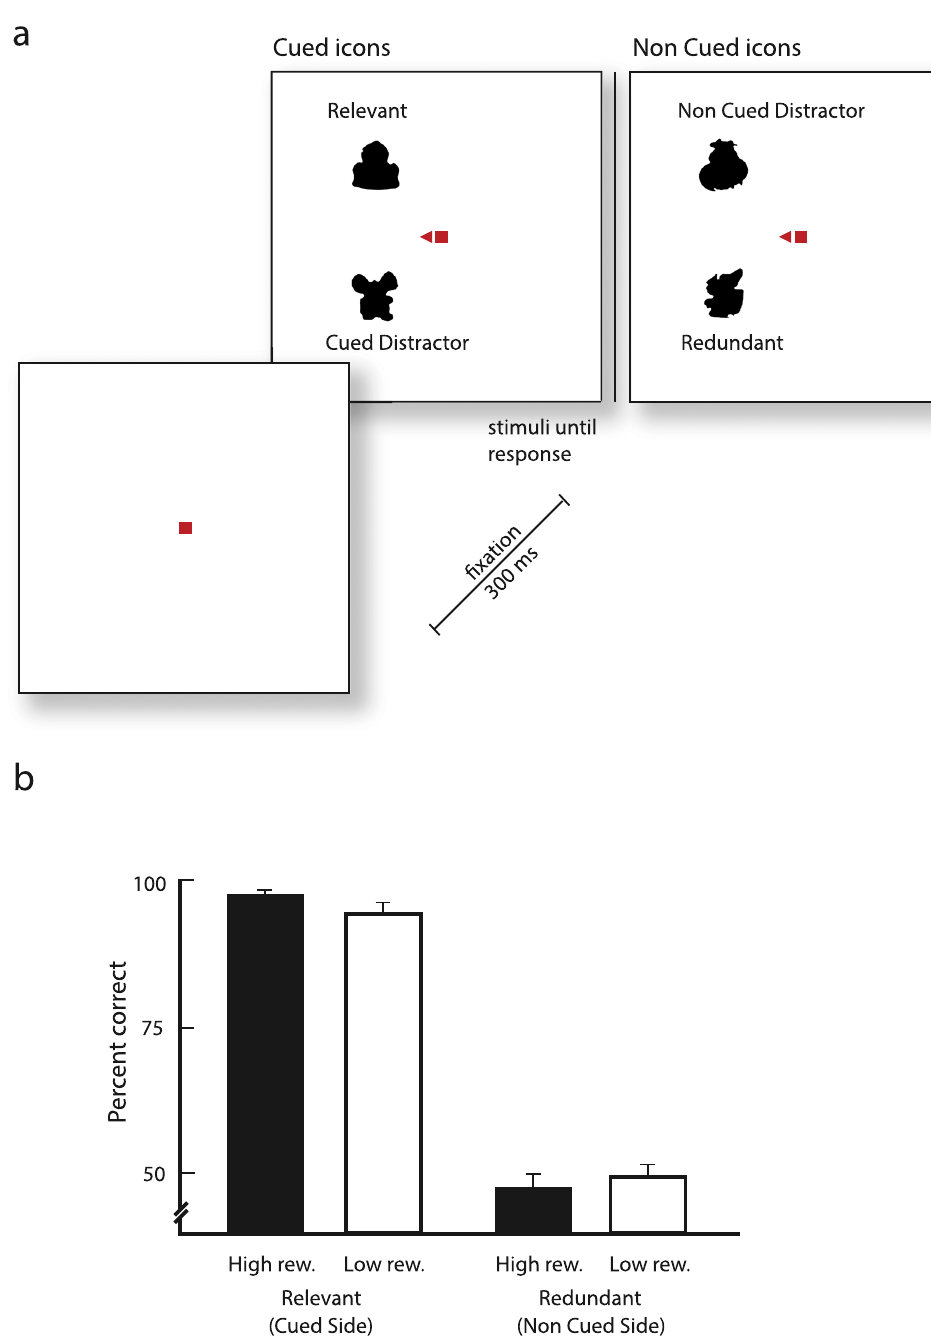
Figure 2. Probe task testing the influence of attention on learning. ( a ) Trial structure. Participants saw icons that had been cued during learning (a relevant icon and a cued distractor) or icons that had not been cued (a redundant icon and a non-cued distractor). We gave no feedback on whether the response was correct or erroneous to prevent additional learning. ( b ) Accuracy in the probe task for icons that had or had not been cued during learning. Black (white) bars denote the accuracy for icons that had been associated with a high (low) reward. Error bars represent standard error of the